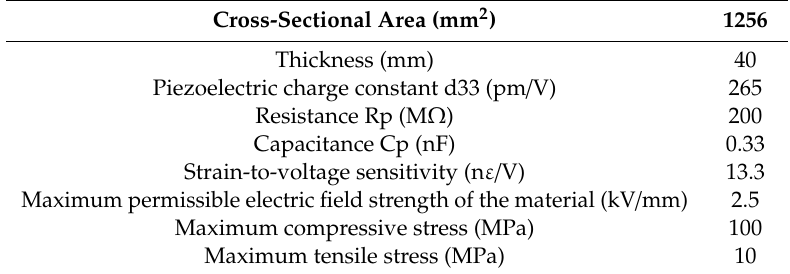
Table 4. Specifications of the PIC181 piezoelectric material utilized for the MV PVT device.